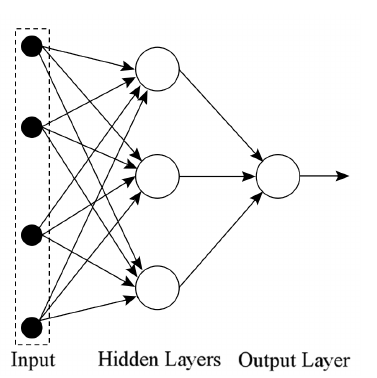
Fig. 2 Fully-connected neural